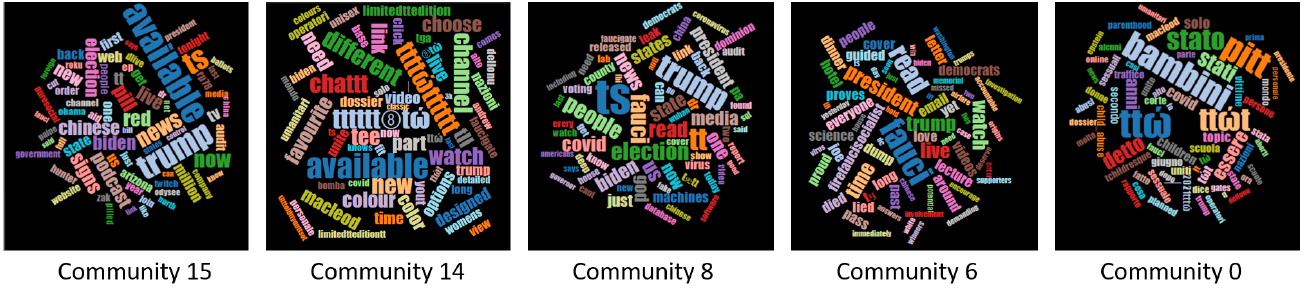
Figure 11. Telegram word